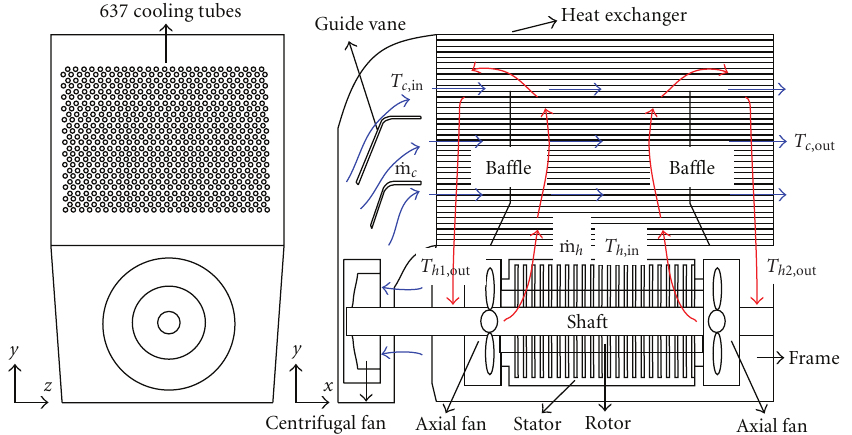
Figure 1: Schematic view of flow paths and components for the motor.